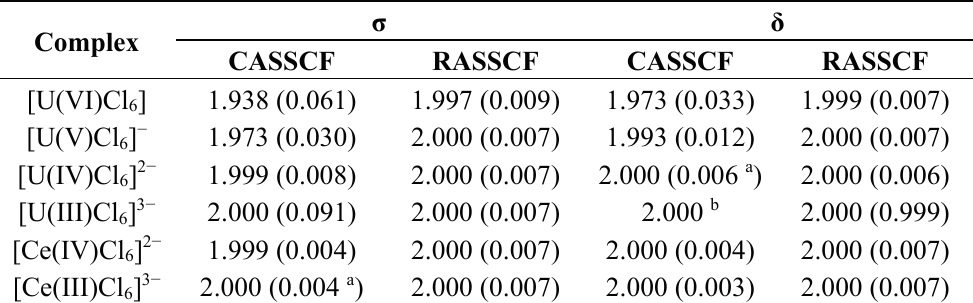
Table 3. RASSCF and CASSCF natural orbital occupancies of bonding (antibonding) orbitals in metal hexachlorides. All values are averaged of three equivalent orbitals except where f-electron occupation breaks this equivalency. a average taken over two weakly occupied orbitals; b no weakly unoccupied orbitals present.